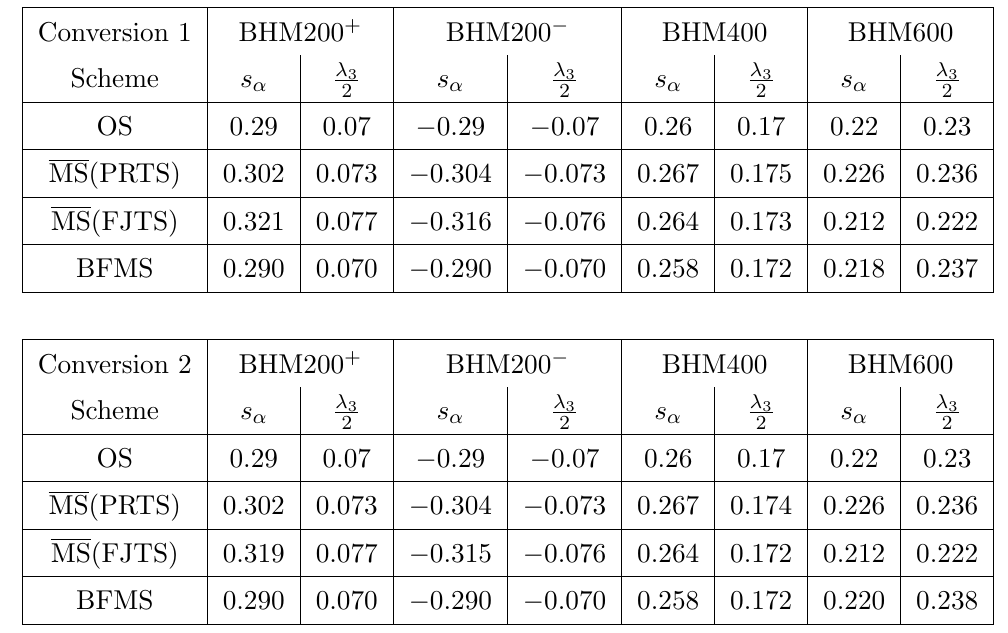
Table 14 . Conversion of parameters from the OS scheme as input scheme to other renormalization schemes at the central scale (cid:22) = M H performed in the PRTS (upper table, used for the Higgs 2